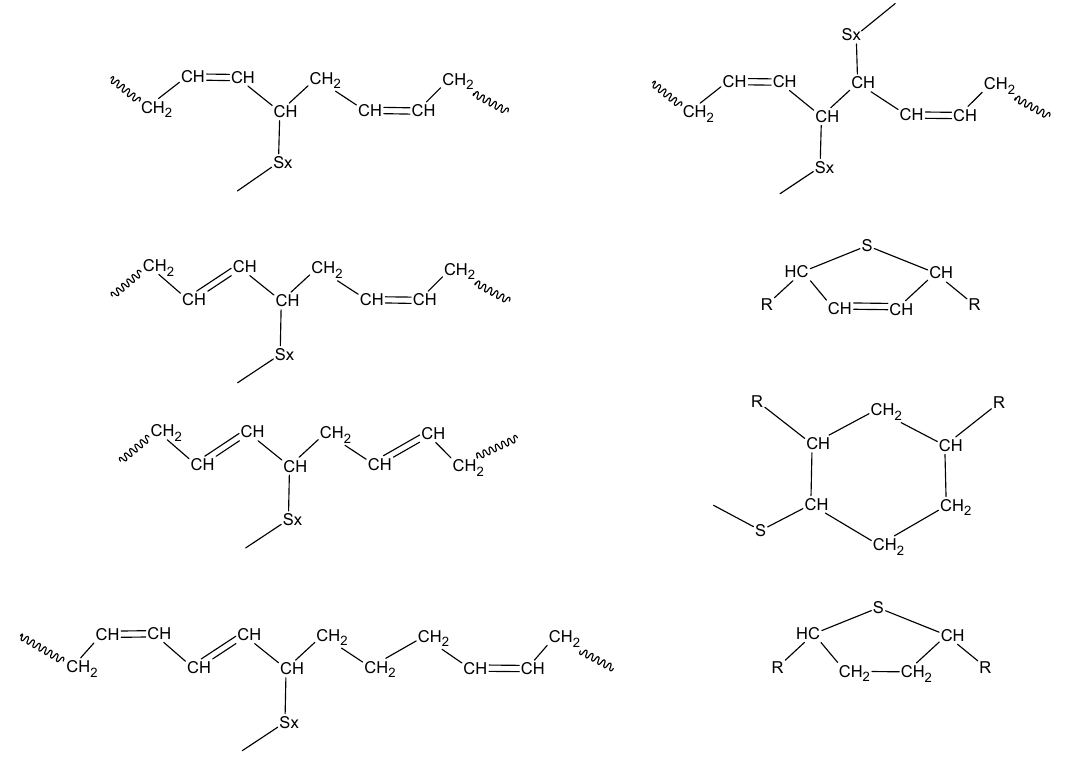
Figure 5. Proposed structures that are produced through the vulcanization of cis -PI [38]. Adapted with permission from Ref. [38]. Copyright (2022) Elsevier Inc.